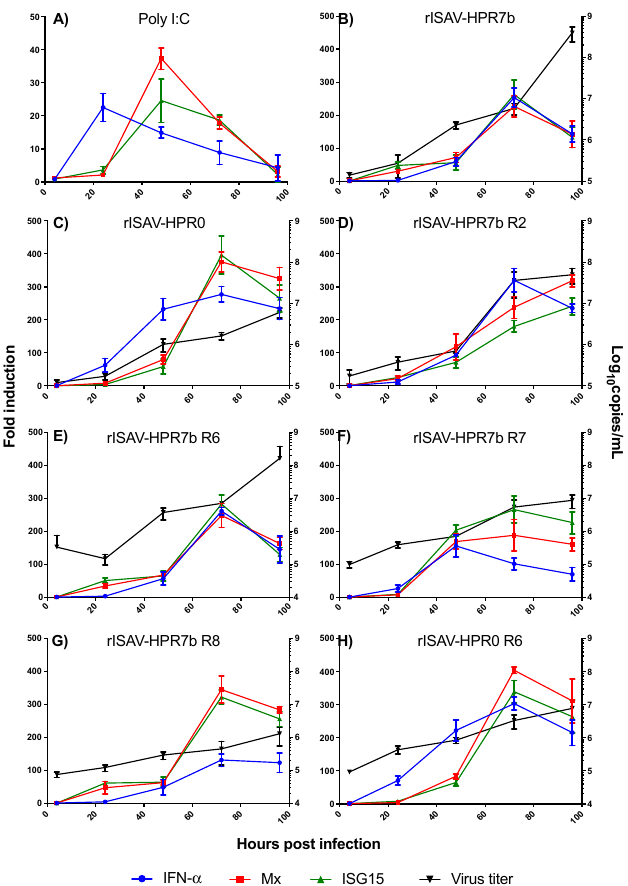
Figure 8. IFN- α , Mx, and ISG15 expression profile induced by reassortant rISAV infection in ASK cells. Relative gene expression (left Y-axis) of IFN- α (blue), Mx (red), and ISG15 (green) genes in ASK cells following rISAV infection. Gene expression and viral titer (right Y-axis, black) were measured at 4, 24, 48, 72, and 96 hpi. ( A ) Expression profile induced by 20 µ g/mL poly I:C treatment. ( B ) Expression profile induced by rISAV-HPR7b infection. ( C ) Expression profile induced by rISAV-HPR0 infection. ( D ) Expression profile induced by rISAV-HPR7b R2. ( E ) Expression profile induced by HPR7b R6. ( F ) Expression profile induced by rISAV-HPR7b R7. ( G ) Expression profile induced by rISAV-HPR7b R8. ( H ) Expression profile induced by rISAV-HPR0 R6. Fold induction and viral titers ± SEM from two independent